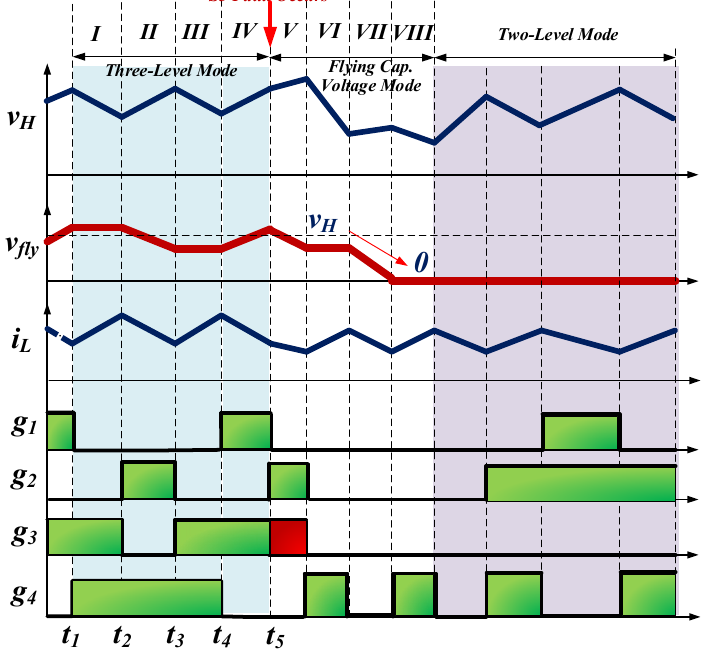
Figure 4. Stages analysis when short-circuit fault occurs in S 3 (V L < 0.5 V H ).